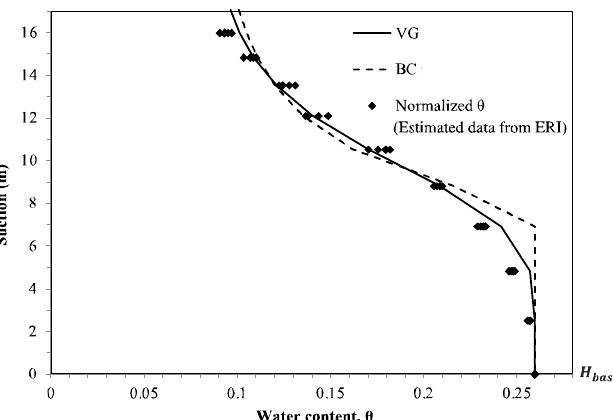
Figure 7. Soil–Water Characteristic Curve (SWCC) for 5 selected vertical profiles of the normalized volumetric water content from 1-D vertical resistivity of PT06 is indicated by a diamond symbol. The dashed curve represents the fitted BC results to the normalized volumetric water content obtained from resistivity measurements, while the solid curve indicates the fitted VG results.